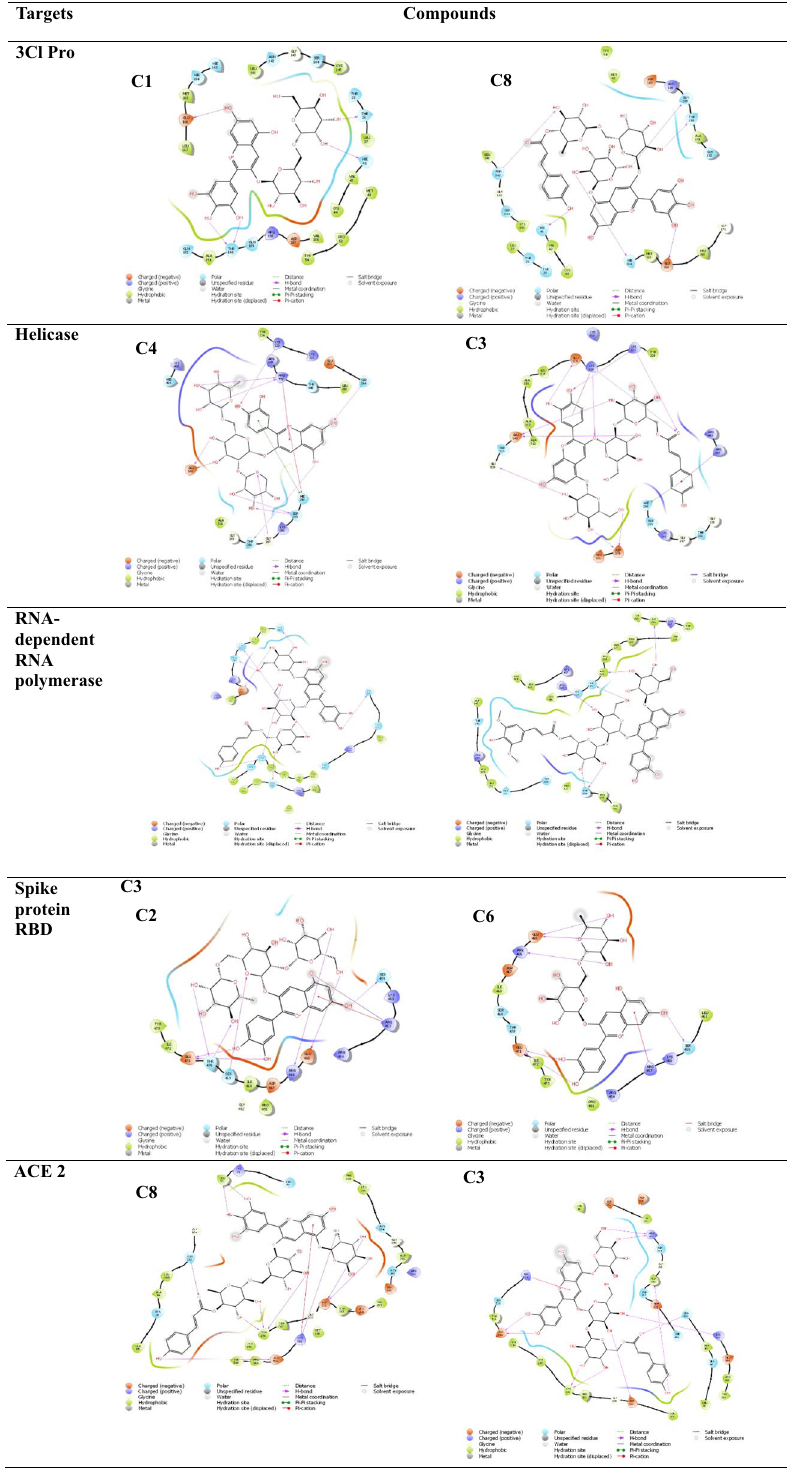
Table 3 2D Amino acid interaction of the top-scoring compounds